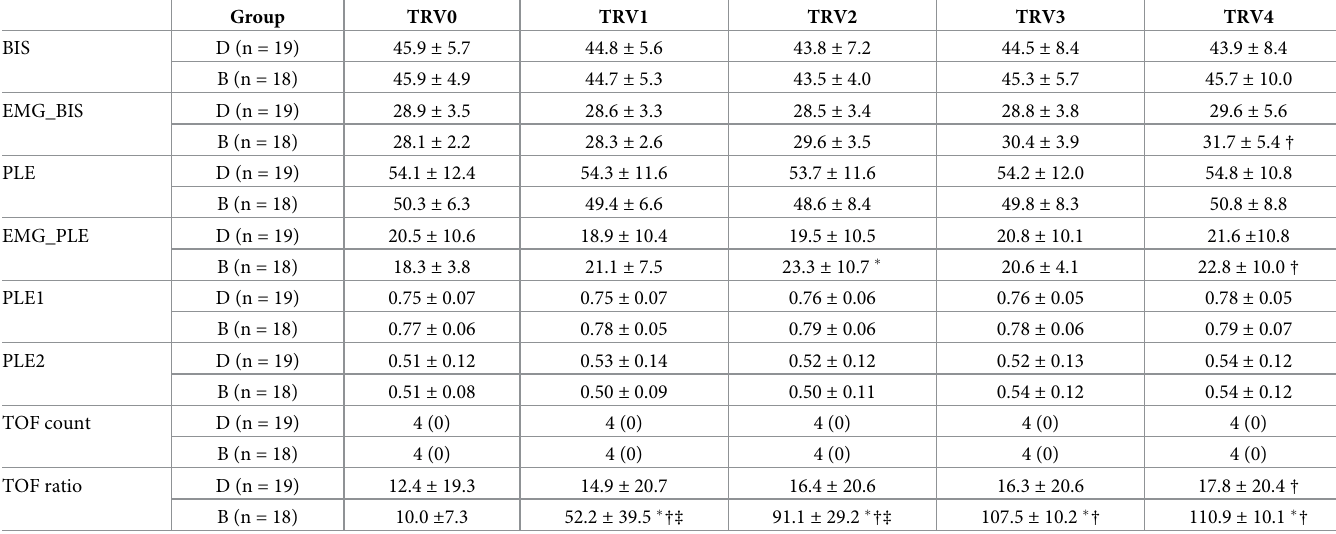
Table 8. Changes in BIS and PLE after administration of study drug at the end of surgery.